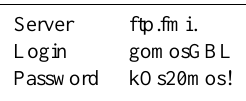
Table 4. Login information for accessing the GBL